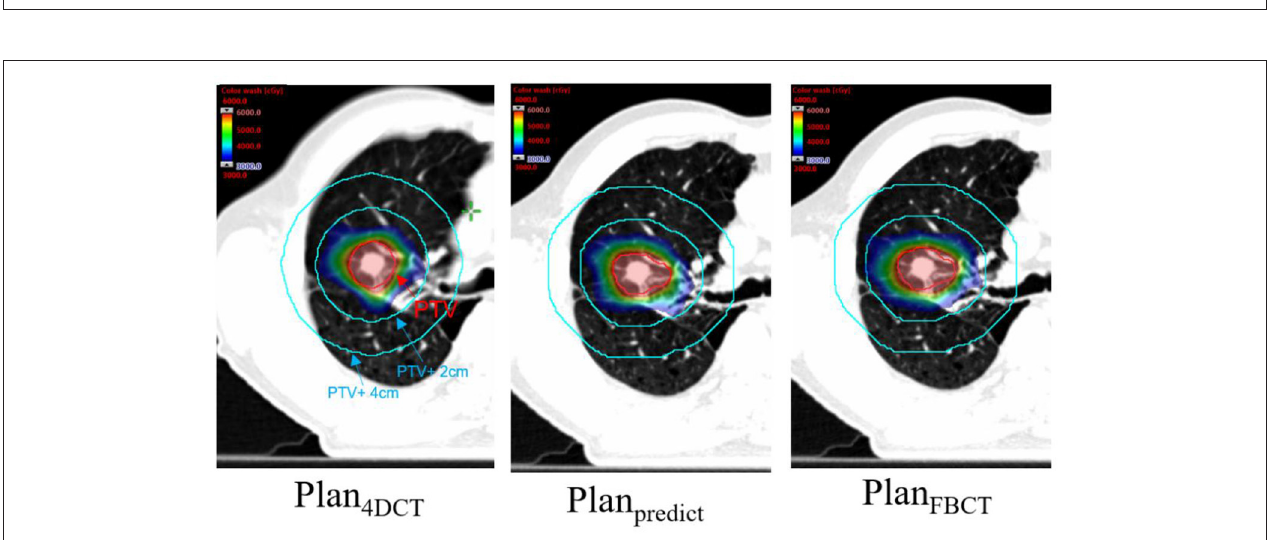
FIGURE 5 | Dose color wash map of each plan for PTV (the area of the red line is PTV, and the red and blue color wash maps represent the 100 and 50% prescription doses,